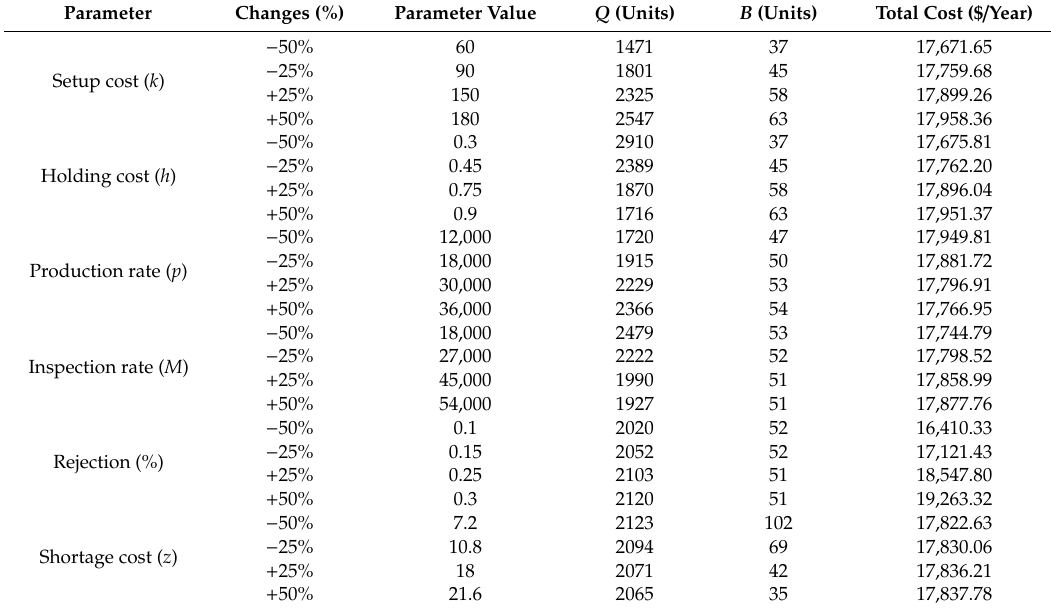
Table 6. Sensitivity analysis (Example